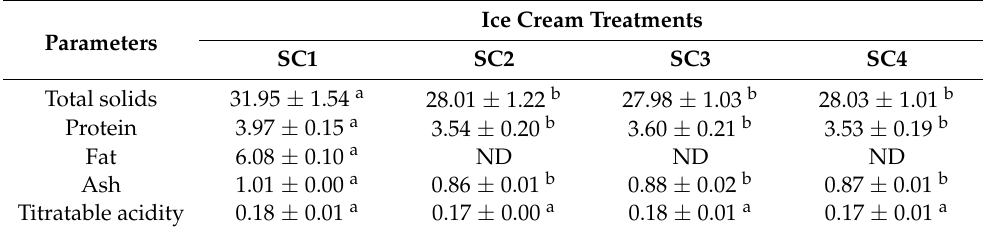
SC1: control without artificial sugar; SC2: ice cream with stevia; SC3: ice cream with sucralose; SC4: ice cream with sorbitol; ND: not detected; a and b : means with different superscript letters within the same row differ significantly ( p < 0.05).